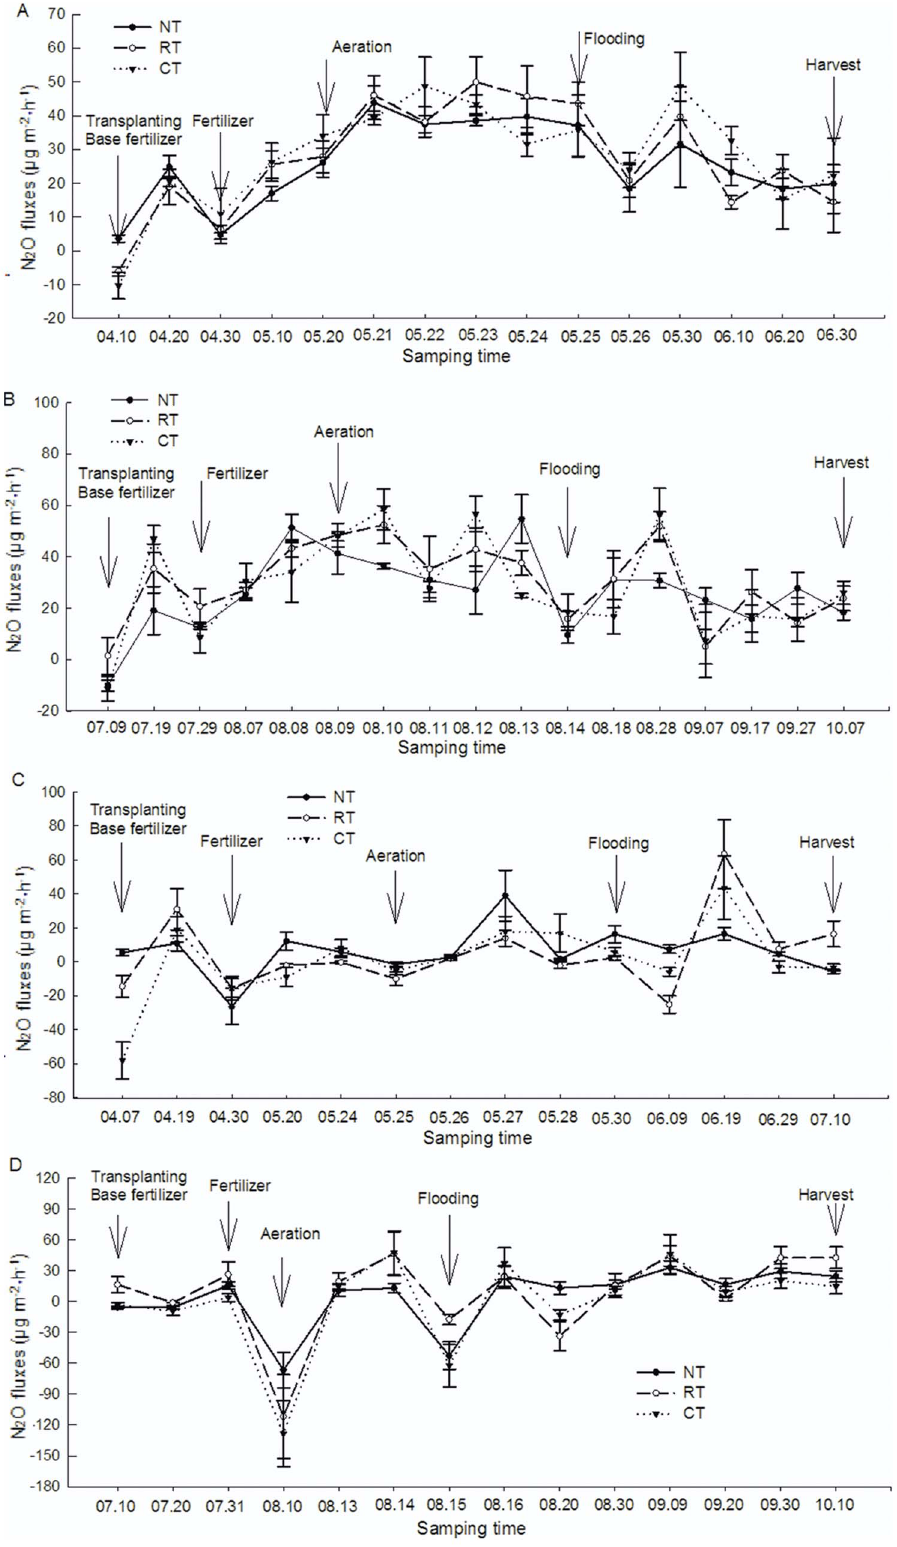
Figure 5. N 2 O flux under different tillage during the rice growing seasons (A, B for the early rice season and the late rice season in 2007; C, D for the early rice season and the late rice season in 2008, respectively). Vertical bars represent standard errors of the mean (n=3).The arrows in the figures indicate the time of field operations.